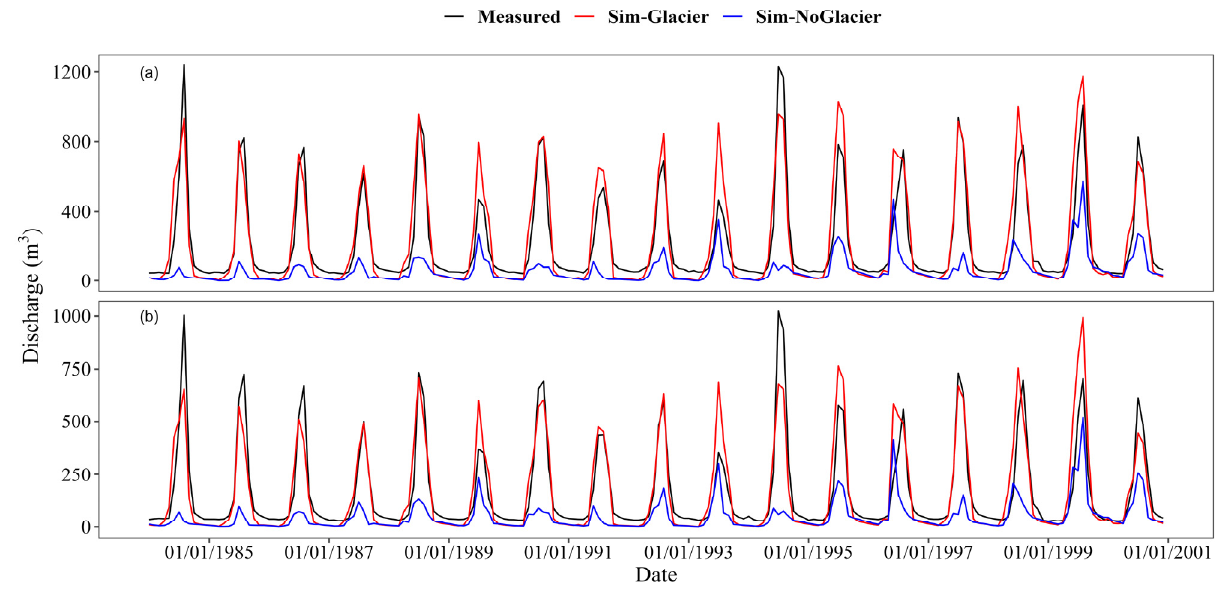
Figure 5. Comparison of simulated and measured monthly discharge rate before calibration (1984–2015), ( a ) Kaqun station, ( b ) Kuluklangan station.